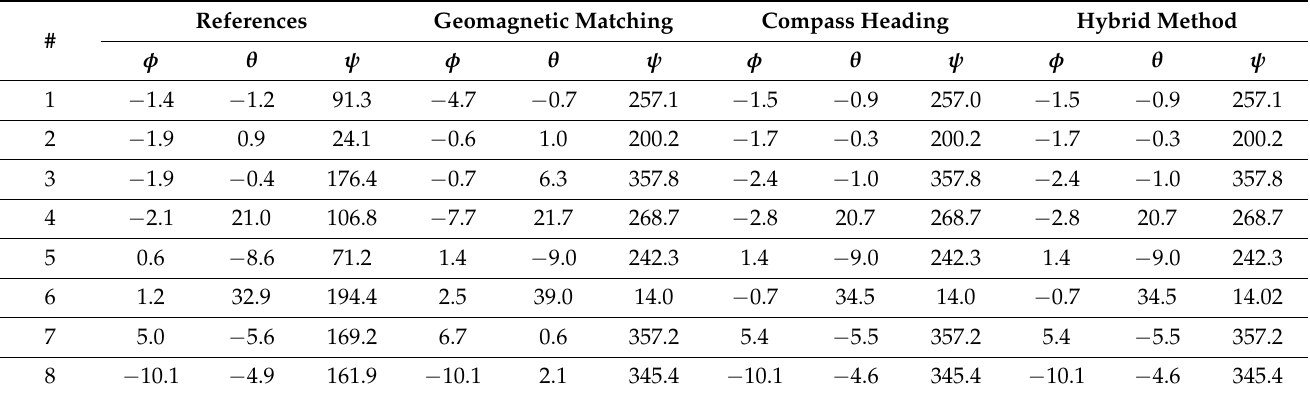
Table 1. Mean error in coarse alignment